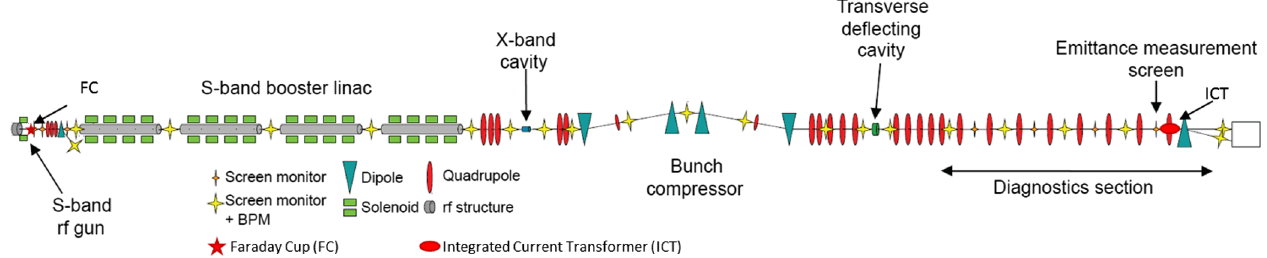
FIG. 1. SITF schematic layout (not in scale). The position of the faraday cup and the integrated current transformer used to measure the dark current are also indicated. The total length of the facility is about 60